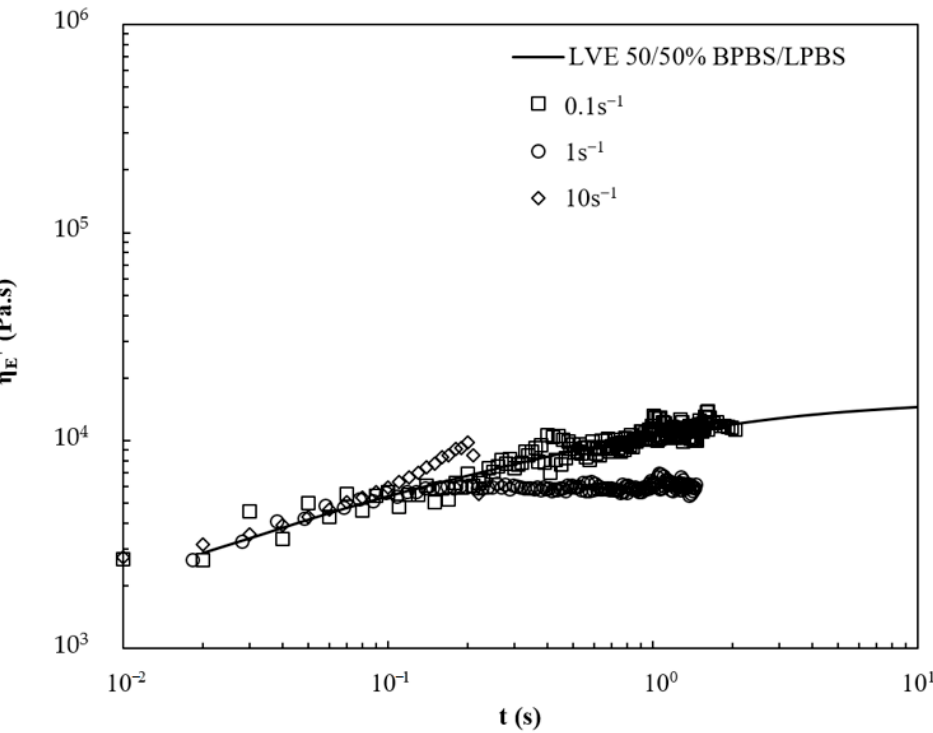
Figure 10. Viscosity curves under extensional flow at various strain rates for 50/50% BPBS/LPBS at 150 °C.